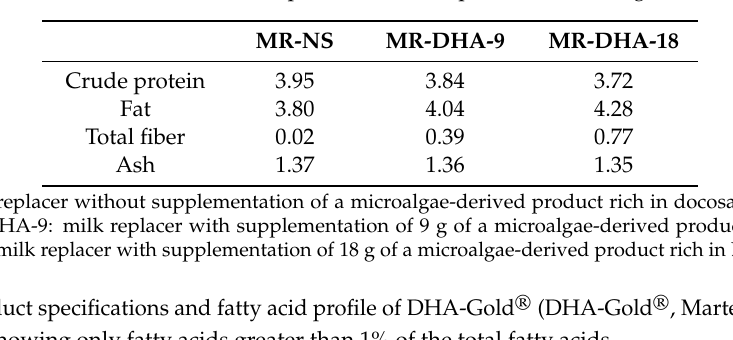
Table 1. Chemical composition of the experimental diets (g / L).